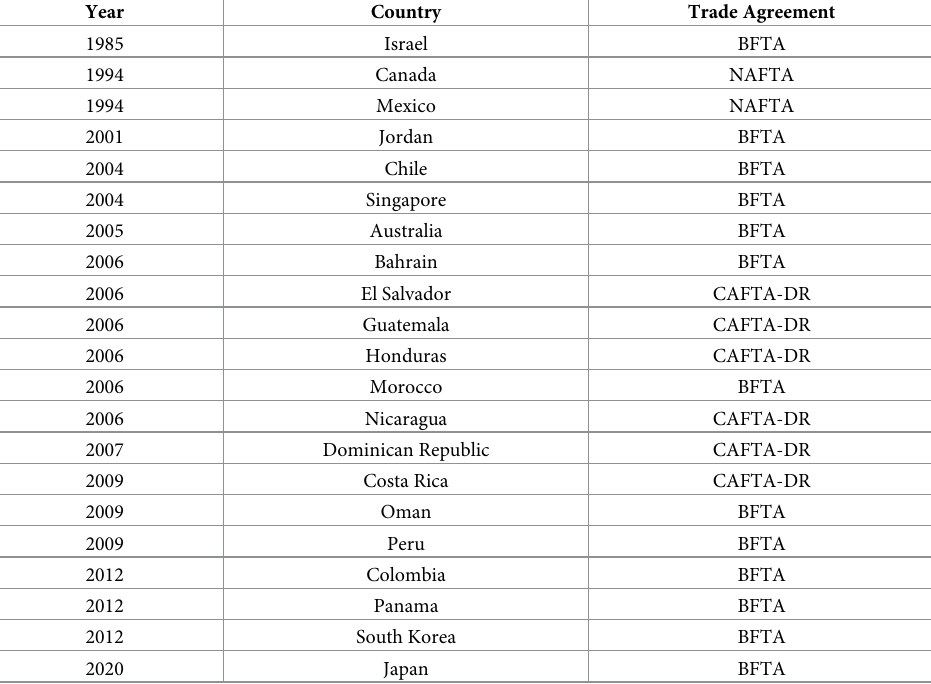
Table 1. Years of establishment of all FTAs and trade members from 1992 to